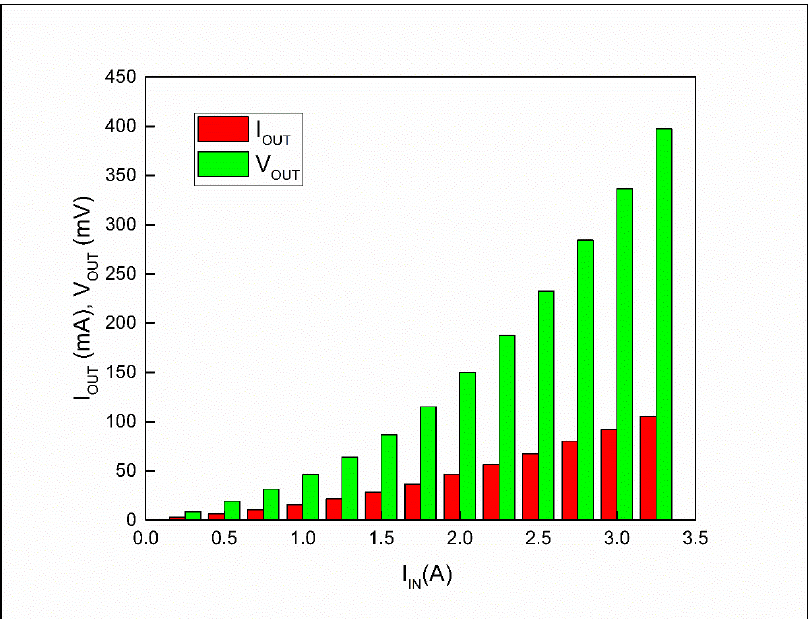
Figure 6. Dependence of OUT V , OUT I on input current.